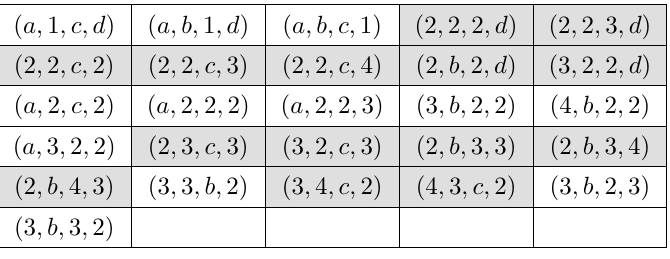
Table 12 . Infinite sequences of type XI singularities. Gray entries are reducible to previous types of singularities. This table is adapted from